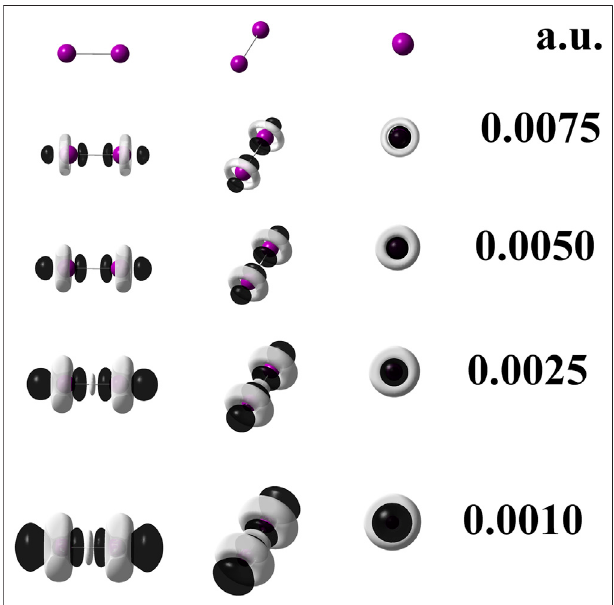
FIGURE 1 | Dual descriptor (DD) of diiodine computed at the M06 – L/ UGBS1p//M06 – L/def2-QZVPPD level of theory at different isovalues given in atomic units. To use Eq. 2 , the following total electron densities were employed: ρ ( r ) 2 107 , ρ ( r ) 1 106 , and ρ ( r ) 3 104 . Purple spheres stand for iodine atoms, black – colored lobes represent positive values of DD ( f (2) ( r ) > 0); white – colored lobes correspond to negative values of DD ( f (2) ( r ) <